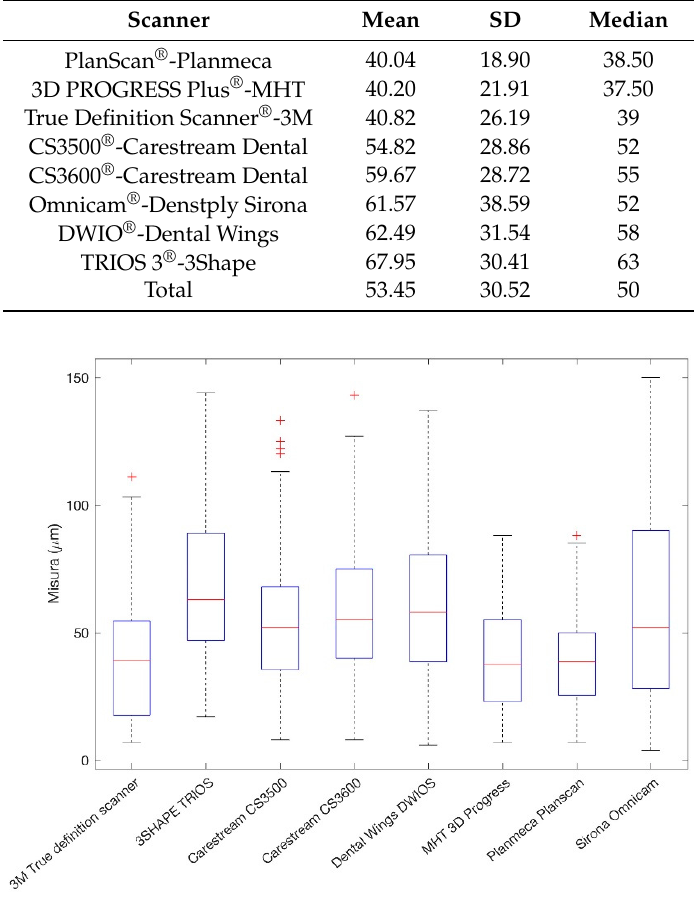
Figure 6. Box-plot representing the sample distribution. Outlier values are indicated by “+” symbols.